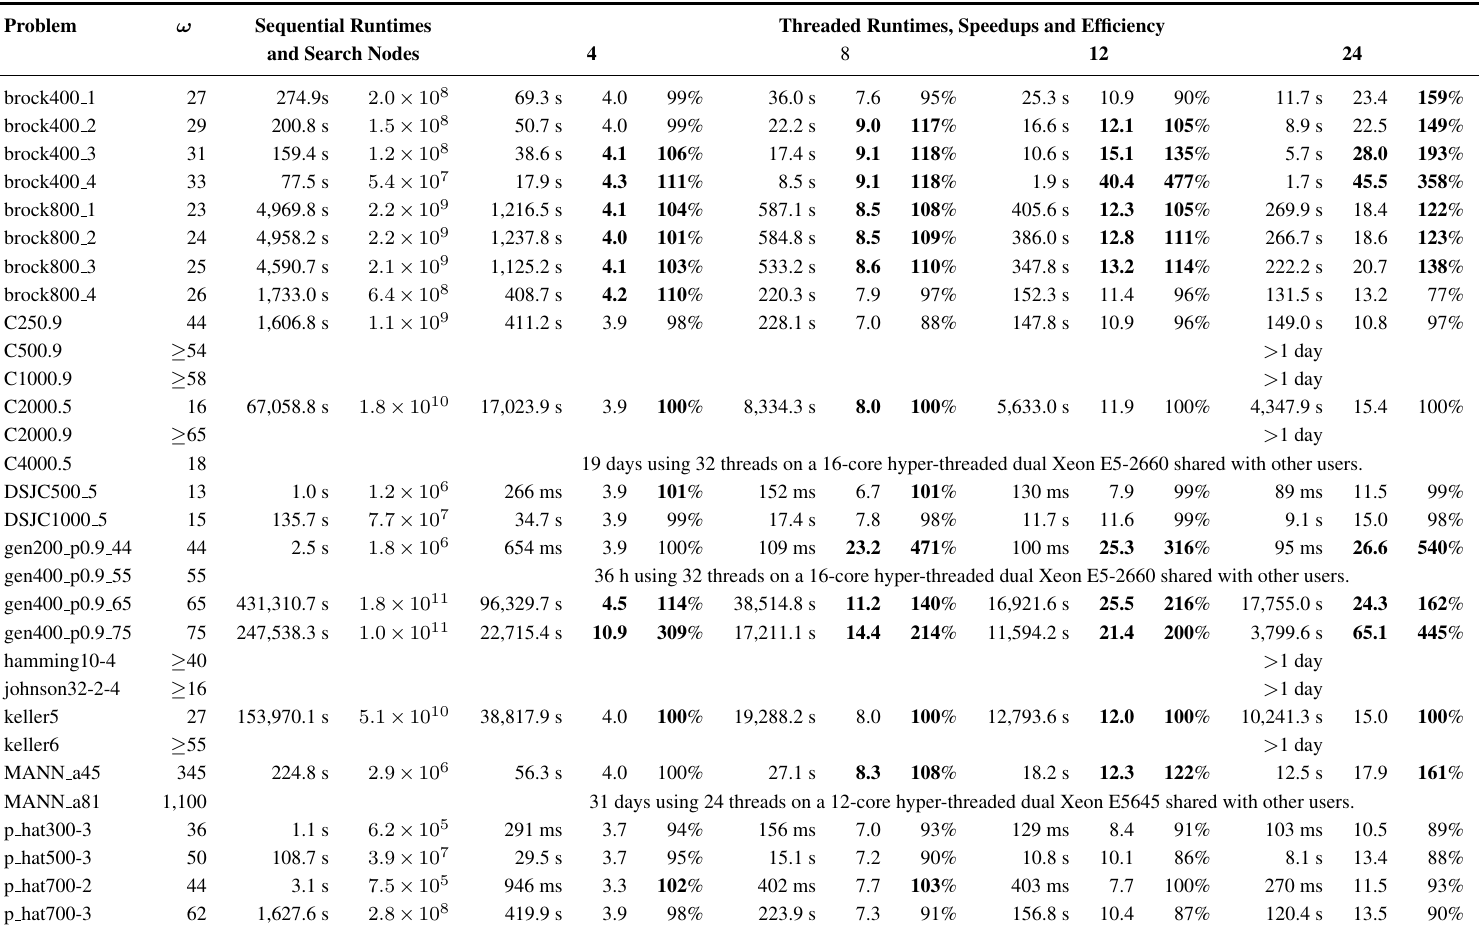
Table 2. Experimental results for DIMACS instances. Shown are the size of a maximum clique, then sequential runtimes and the number of search nodes (calls to expand ). Next is parallel runtimes, speedups and efficiency using 4 to 24 threads on a 12-core hyper-threaded system. Superlinear speedups and efficiencies greater than 100% are shown in bold; blanks indicate unattempted problems. Problems where the sequential run took under one second are